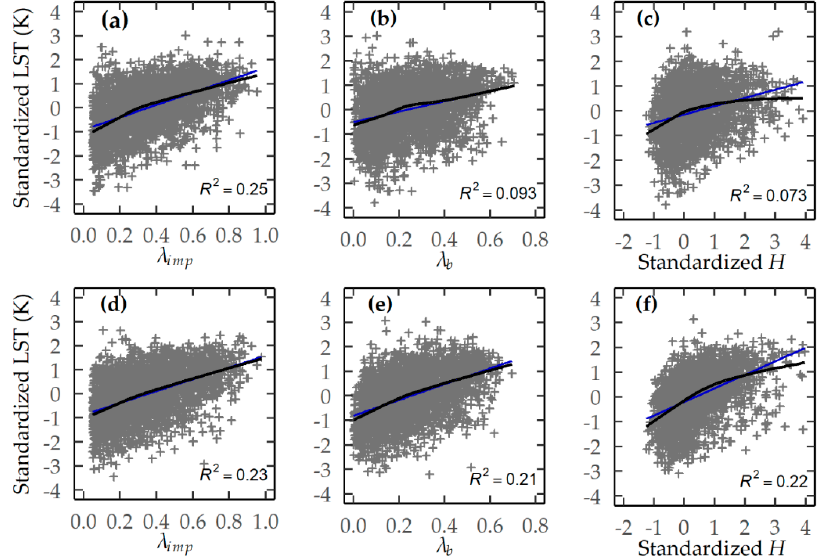
Figure 5. The relationship between LST λ imp , λ b , and H for all cities combined: During daytime ( a – c ), and during nighttime ( d – f ). Black curves correspond to the lowess regression lines. Blue lines and R 2 correspond to the linear regression fit.